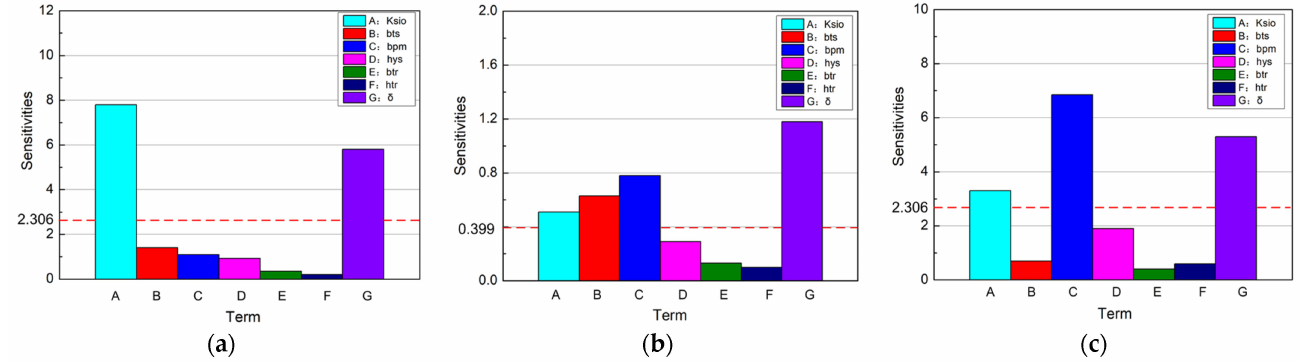
Figure 5. Pareto chart of the sensitivities to output performance. ( a ) Sensitivities to T out ; ( b ) sensitivi- ties to T ript ; ( c ) sensitivities to T out / Q pm .